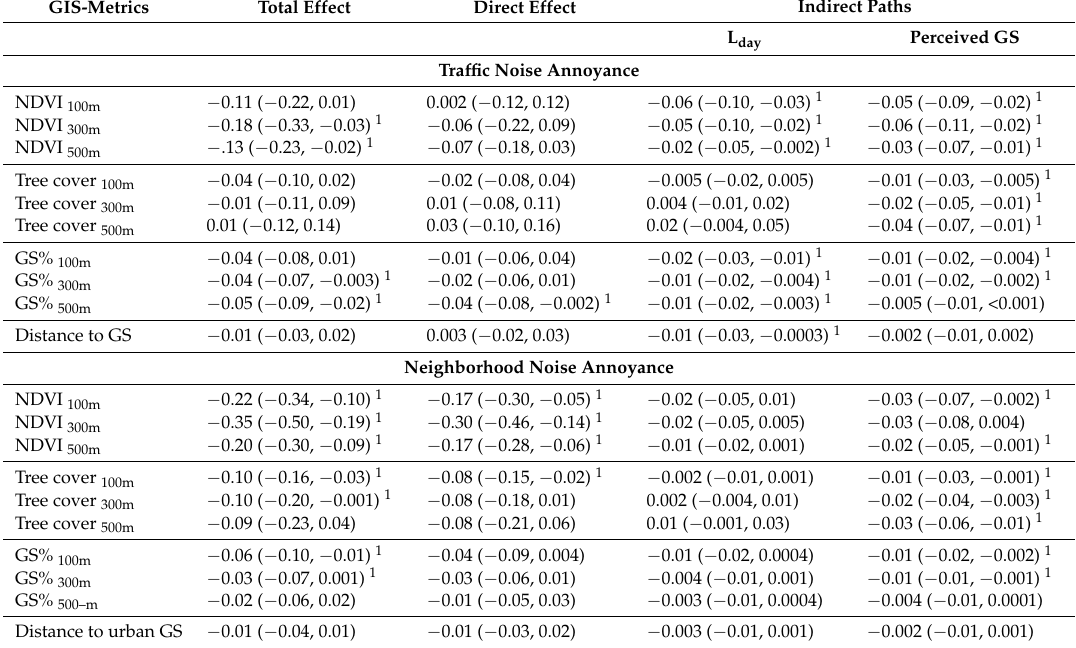
Table A1. Parallel mediation models linking Geographic Information System (GIS)-derived greenspace to traffic- and neighborhood noise annoyances ( N =